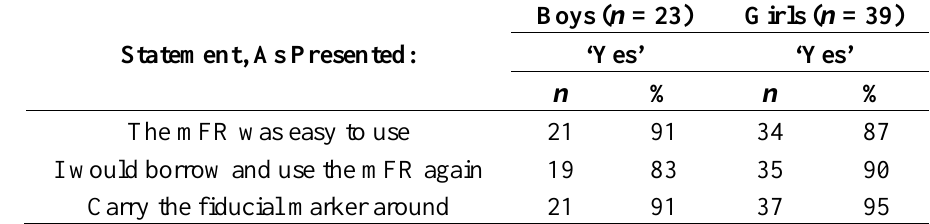
Table 3. Responses to mobile food record (mFR) questionnaire among children, 3–10 years old, in Sample 1 after using the mFR ( n = 62) while at summer camp during